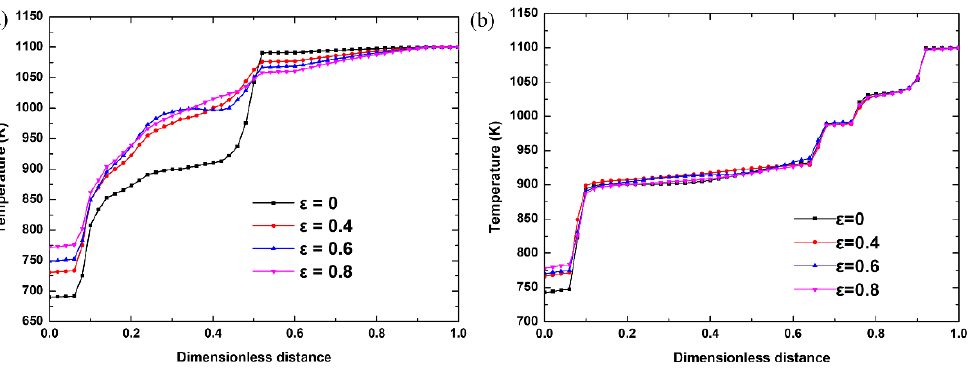
Figure 18. Temperature distribution with the dimensionless position: ( a ) AB; ( b ) CD transversal.